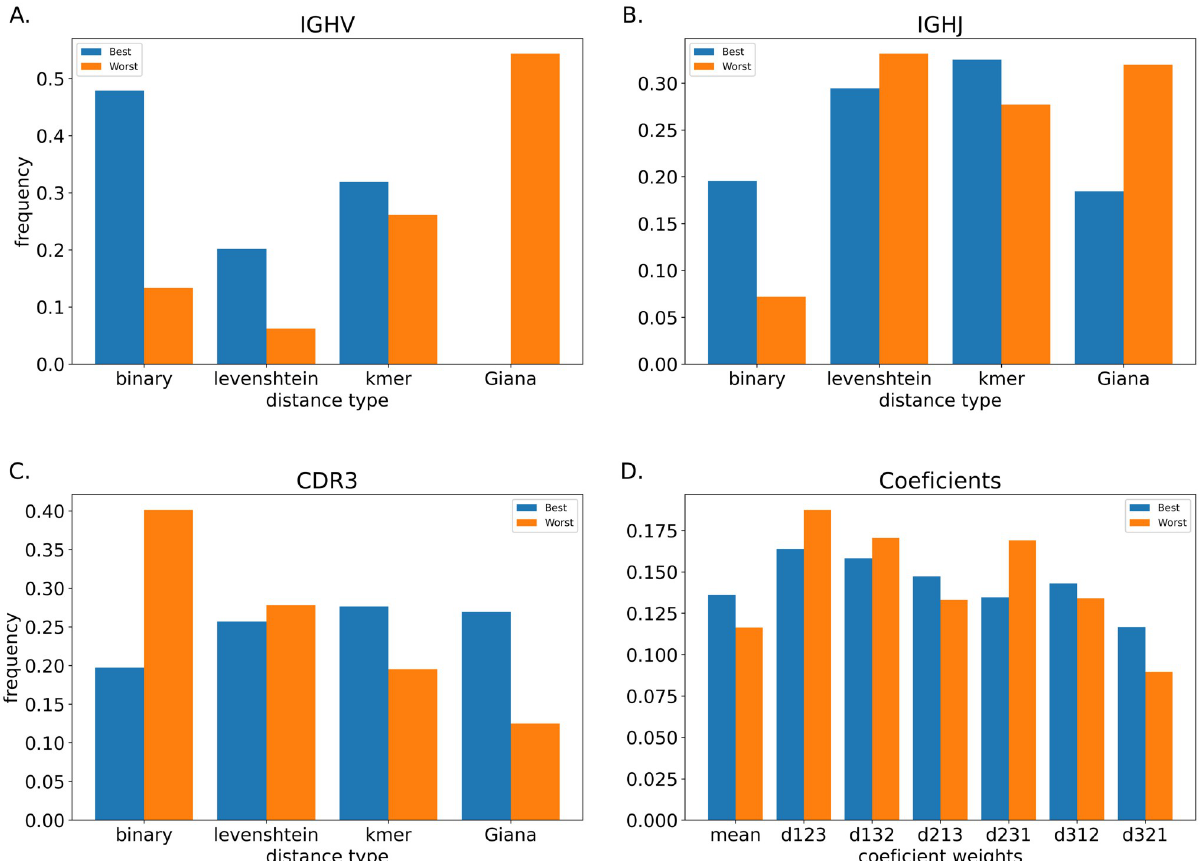
Fig 6. Impact of refinement parameters in the best and worst performance. We averaged F-scores of 12 simulated repertoires and ranked them to form two sets of parameter configurations: those with the best performance (F-score = 1) and those with the worst performance (lowest F-score < 0.7). The ordinate shows parameter frequency and abscissa parameter type. (A, B, and C) show IGHV, IGHJ, and CDR3 distances, while (D) shows coefficient variations. Note that d––– indicates the coefficient values for α , β , and λ respectively, while ‘mean’ represents the arithmetic mean.